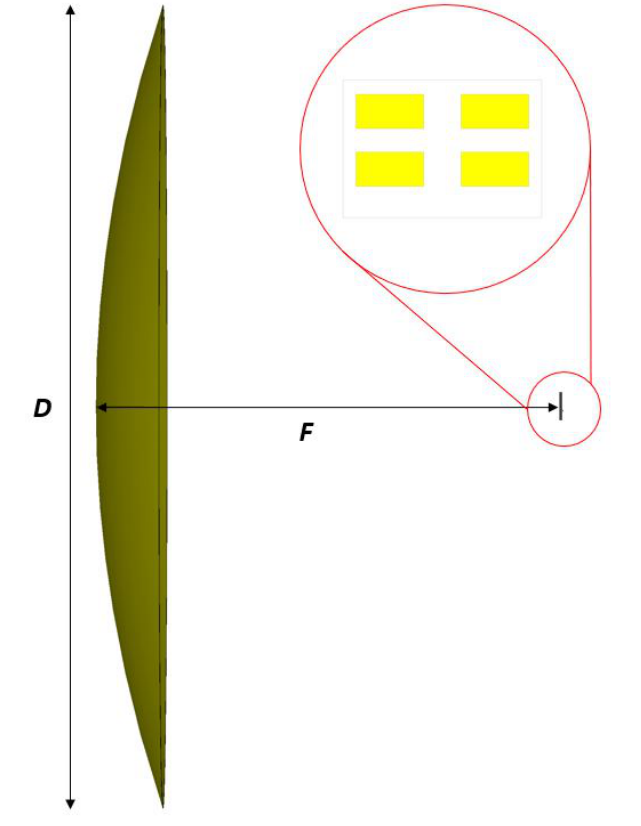
Figure 7. A simulation configuration schematic.